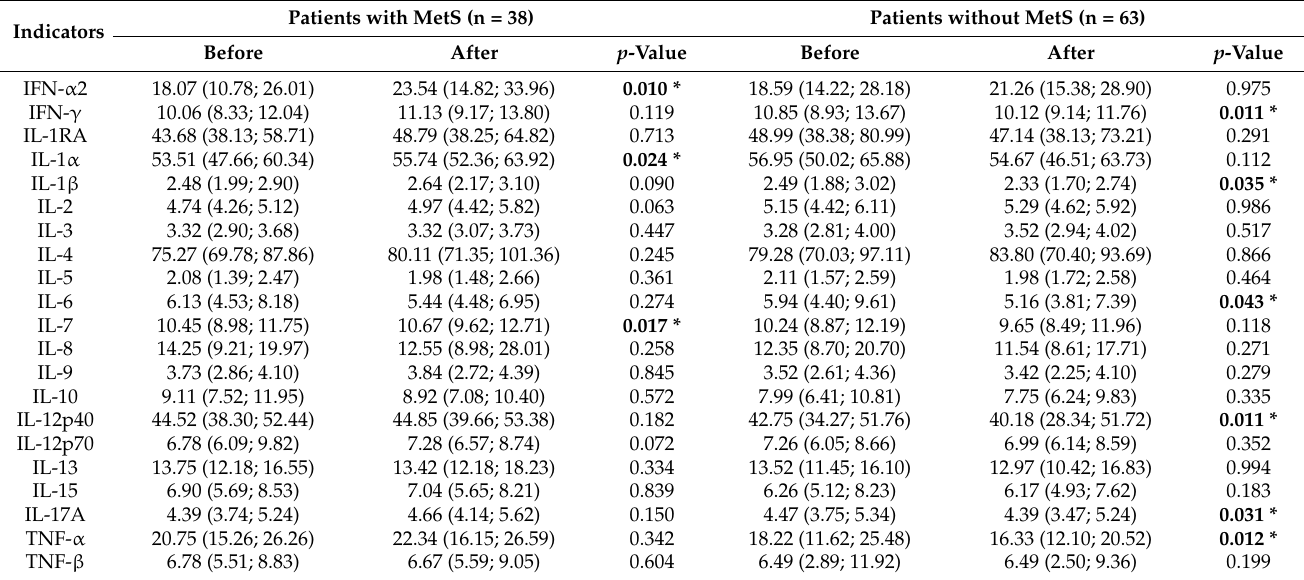
Table 2. Serum concentrations of the cytokines (pg/mL) in patients with and without MetS during 6 weeks of SGA therapy, Me (Q1; Q3). Patients with MetS (n = 38) Patients without MetS (n = 63) Indicators Before